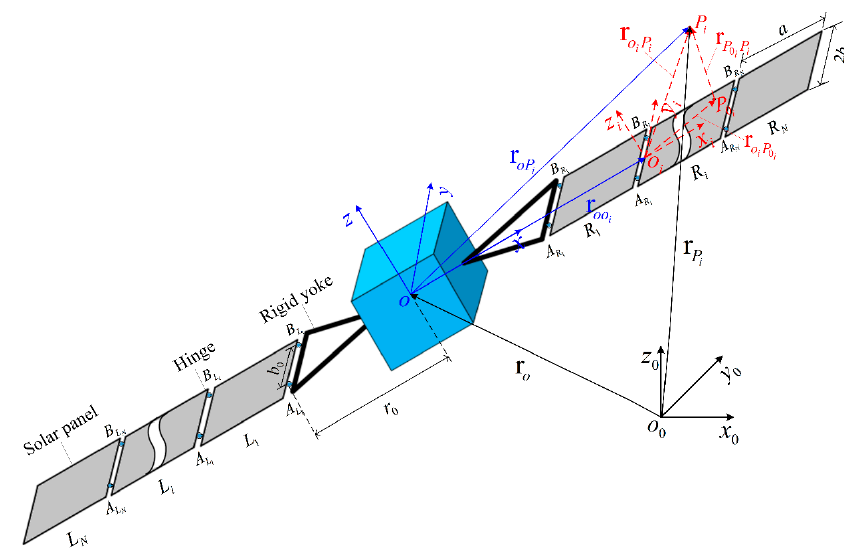
Figure 3. Model of the three-axis a tt itude stabilized LSFS.